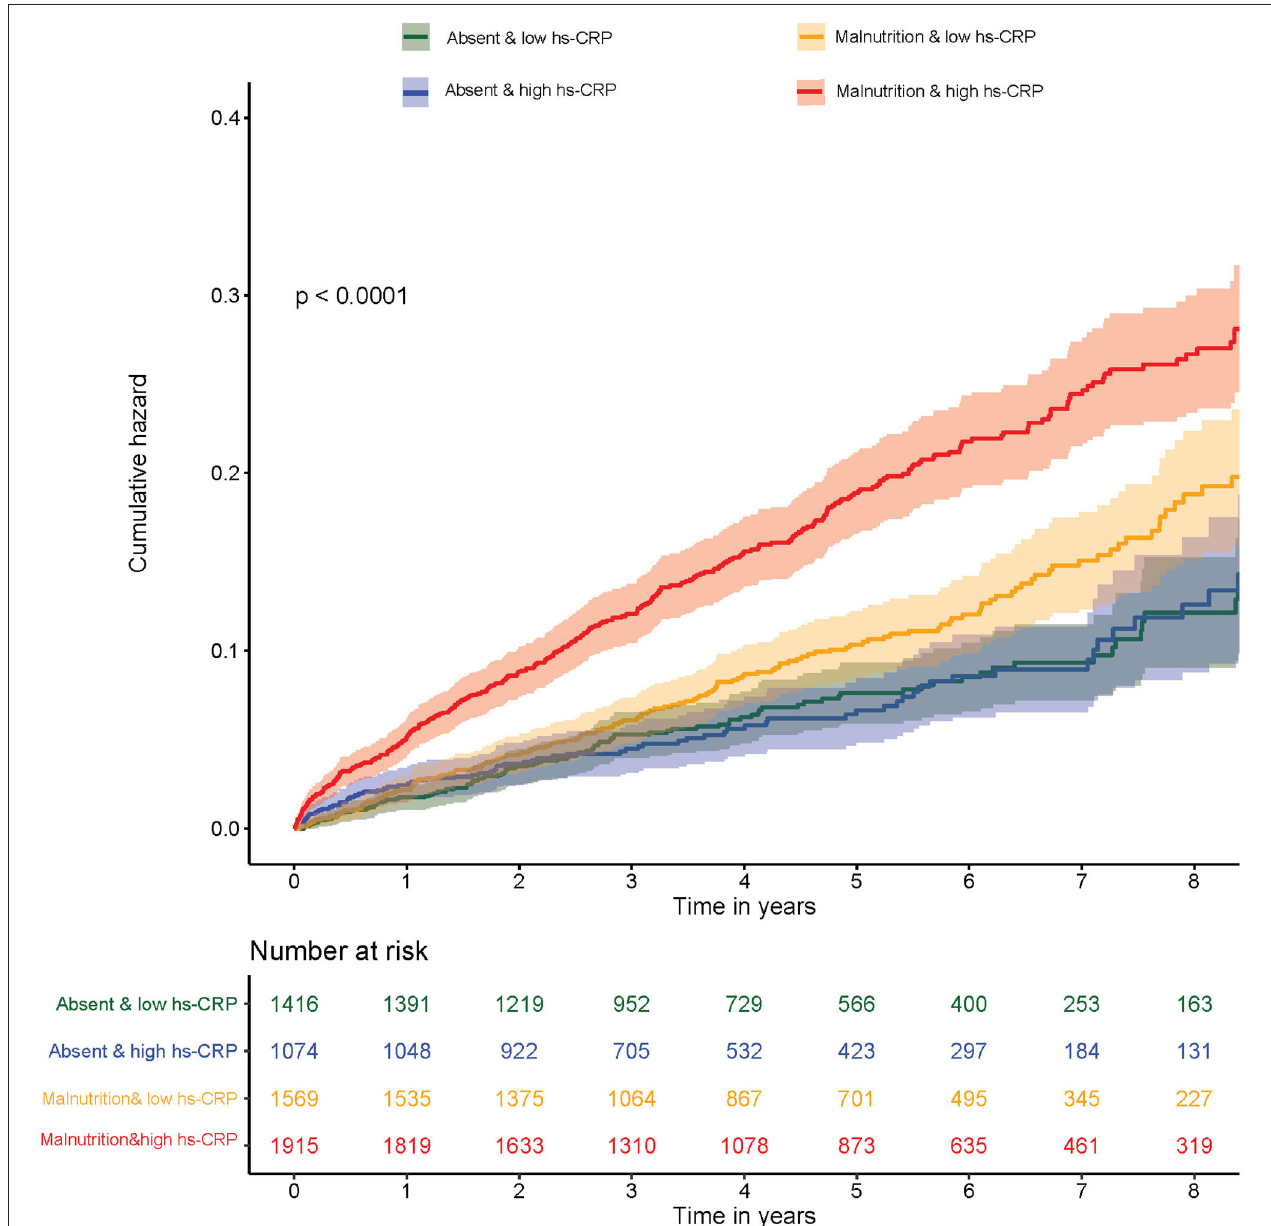
Figure 3 . After controlling for confounding variables, compared with normal nutrition and low hs-CRP level, an isolated condition of either malnutrition or high hs-CRP level was not associated with a significant risk of all-cause mortality. However, concomitant presence of both high hs-CRP level and malnutrition condition were associated with a significantly increased risk of all-cause mortality (HR: 1.51; 95% CI: 1.20–1.89; p < 0.001). The p -value for interaction between nutritional status (normal nutrition vs. malnutrition) and hs-CRP (low hs-CRP level vs. high hs-CRP level) on all-cause mortality was 0.03